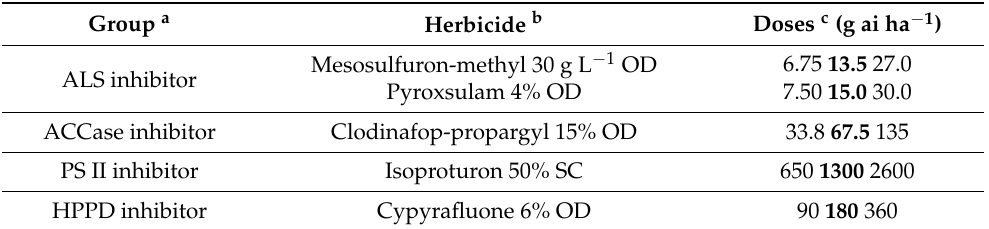
three doses: 0.5 × , 1 × (recommended rate on the tag) and 2 × , and sprayed as previously described. At 21 DAT, the efficacy of the different concentrations of herbicides on each population was evaluated by counting the control rate (fresh weight of the treated plants divided by that of the untreated plants). Each dose–response experiment was set up in a randomized complete block (blocked by population) design, with 10 replicates (pots) per treatment, which were repeated over time. Table 5. Herbicides and their doses used in the cross- and multiple-herbicide resistance experiments. Group